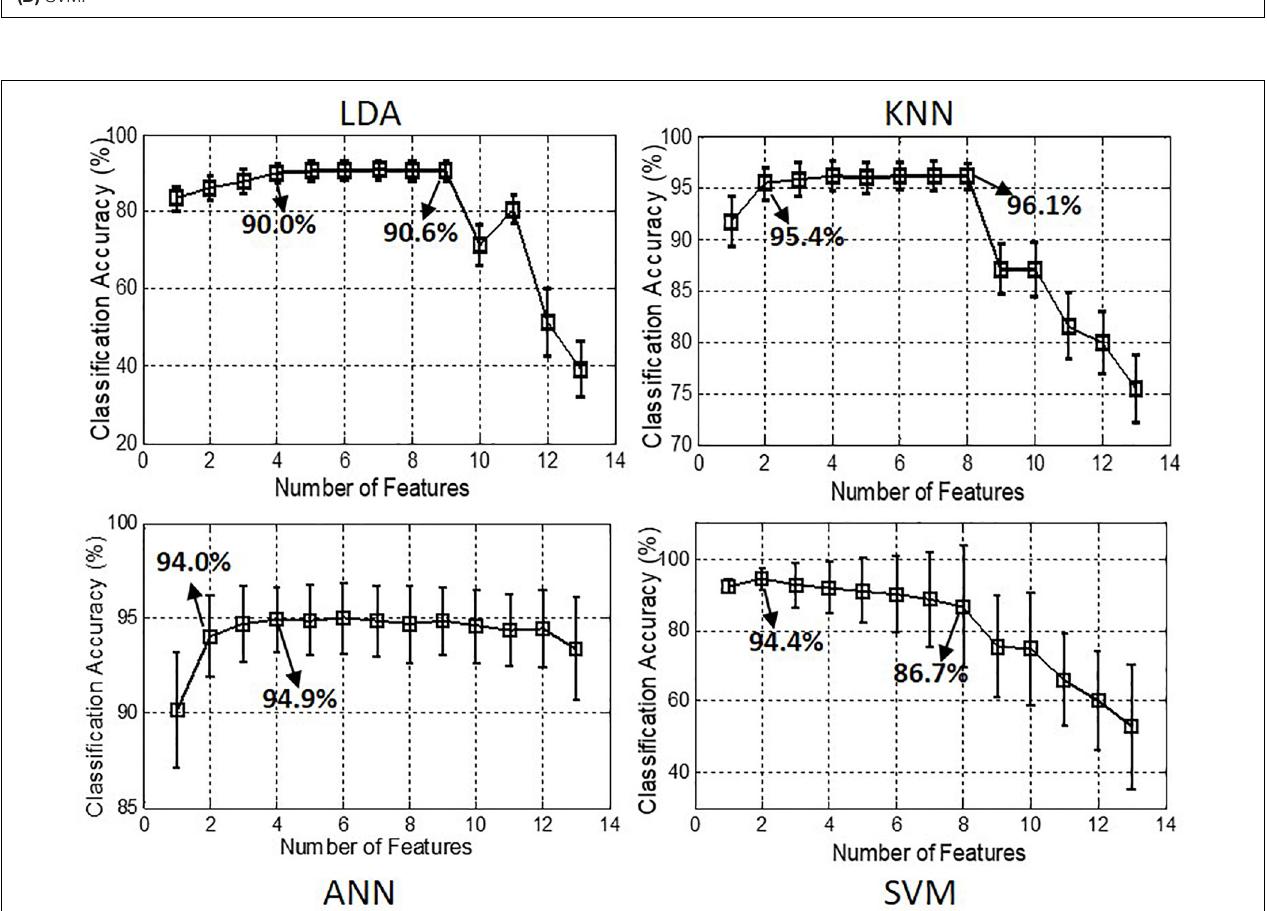
FIGURE 6 | Classification accuracies achieved by using different number of features for classifiers of LDA, KNN, ANN, and SVM, respectively.